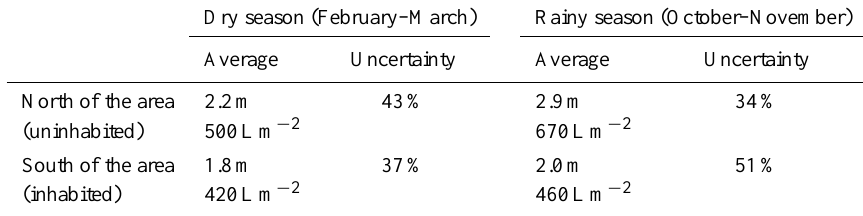
Table 1. Average thickness of the freshwater lens and corresponding freshwater